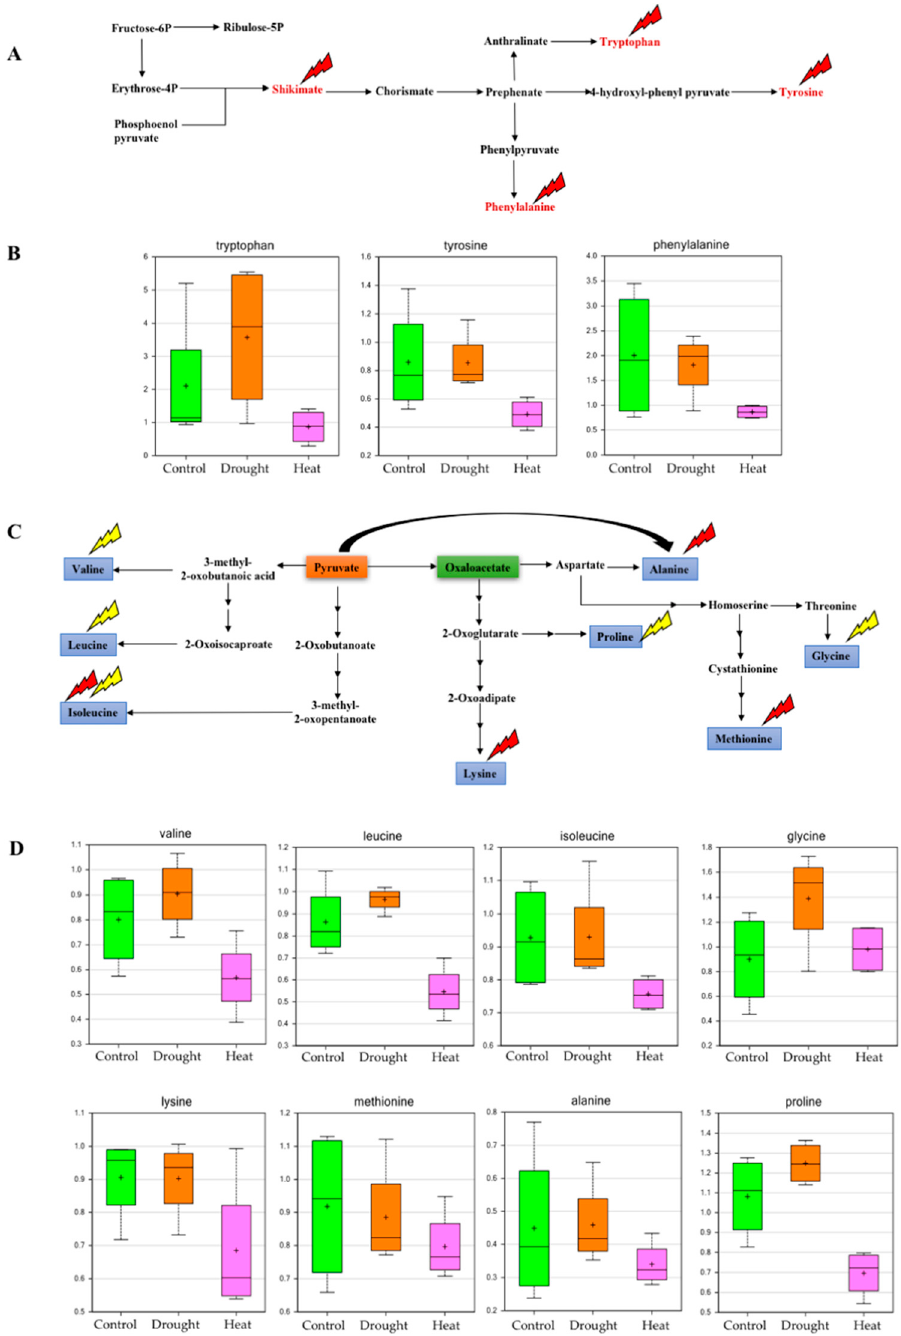
Figure 4. Effect of drought and heat stresses on metabolites of aromatic amino acid metabolism. ( A ) Pathway for aromatic amino acid metabolism showing the metabolites that were found to have significant effect of stresses on their abundance in the study ( B ) Box plots showing the relative abundances of aromatic amino acids in control, drought, and heat stress conditions ( C ) Effect of drought and heat stress on pyruvate and oxaloacetate-derived amino acid biosynthesis ( D ) Box plots showing relative levels of pyruvate and oxaloacetate-derived amino acids in control, drought and heat stress conditions. (Box plot description is the same as in Figure 2; red and yellow lightning signs in ( A ) and ( C ) indicate the effects of heat and drought stress, respectively).